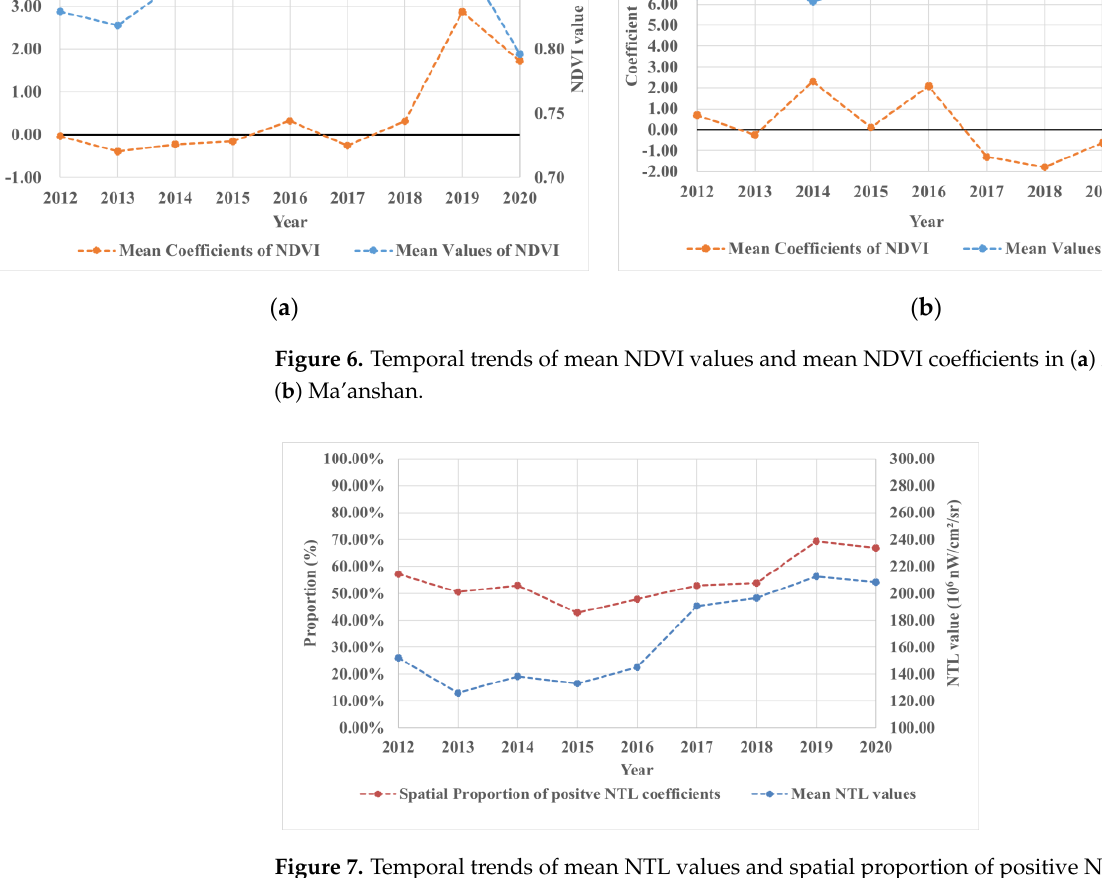
Figure 7. Temporal trends of mean NTL values and spatial proportion of positive NTL coefficients.